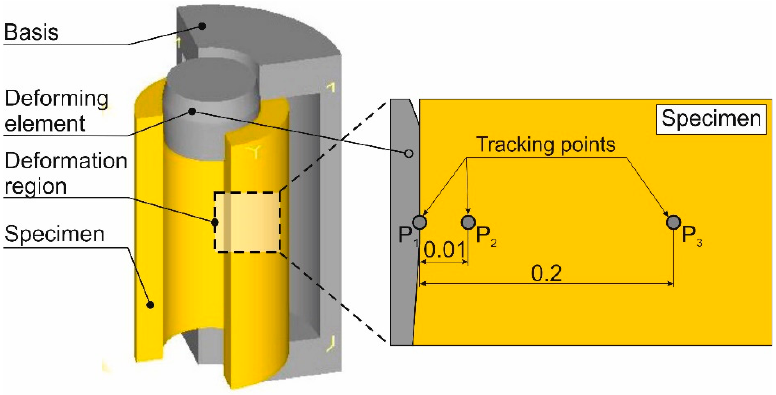
Figure 5. DBR modeling scheme.